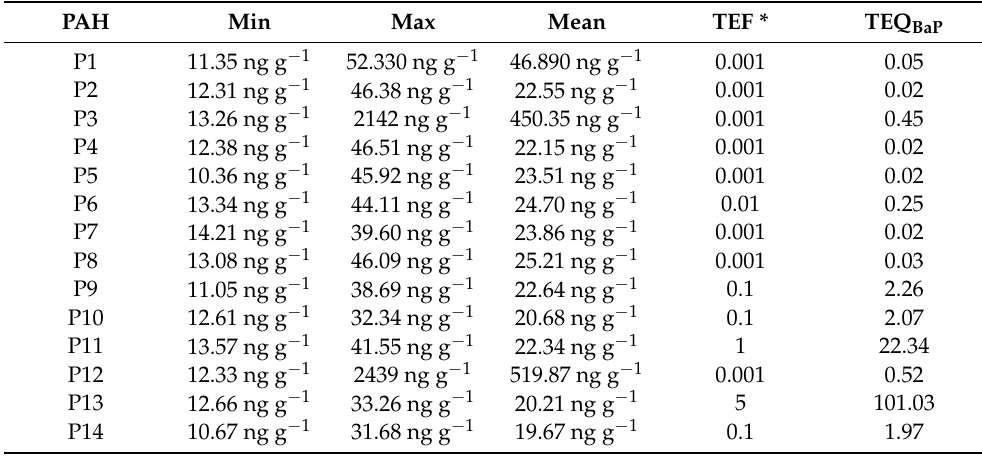
Table 3. Toxic equivalency concentration of 16 PAHs based on